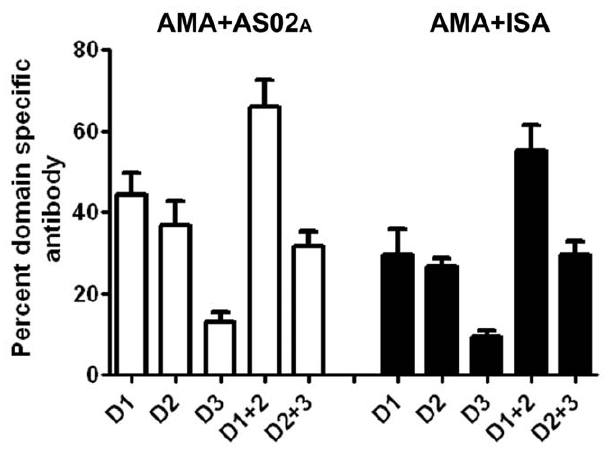
Figure 8. Domain-specificities of AS02 A and ISA720 induced anti-AMA1 were similar. End-point titer was determined against chimeric proteins displaying P. falciparum domains 1, 2, 3, 1 + 2 or 2 + 3 on P. berghei AMA1 scaffold (D1, D2, D3, D1 + 2, D2 + 3 chimeras respectively). Domain-specific titer was calculated by expressing the domain-specific end-point titer as a percentage of titer against the full- length 3D7 AMA1 protein. Mean and standard error for 6 animals per group was plotted.